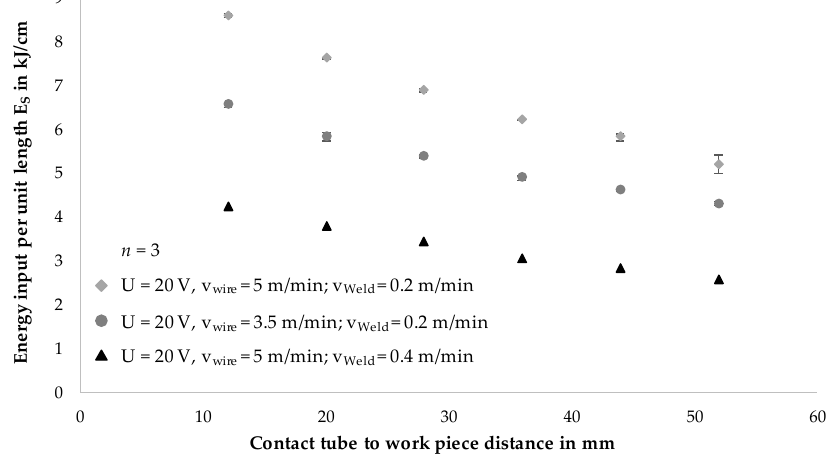
ff ering parameter